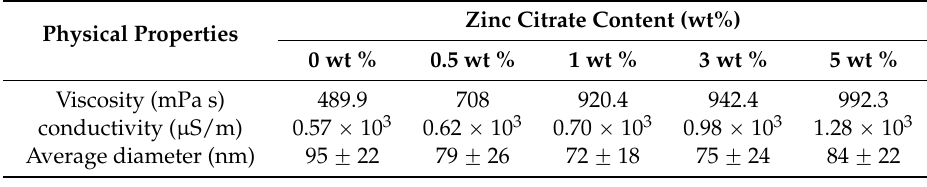
Table 1. Viscosity of polyvinyl alcohol (PVA)/zinc citrate mixtures and specification of nanofiber mats.